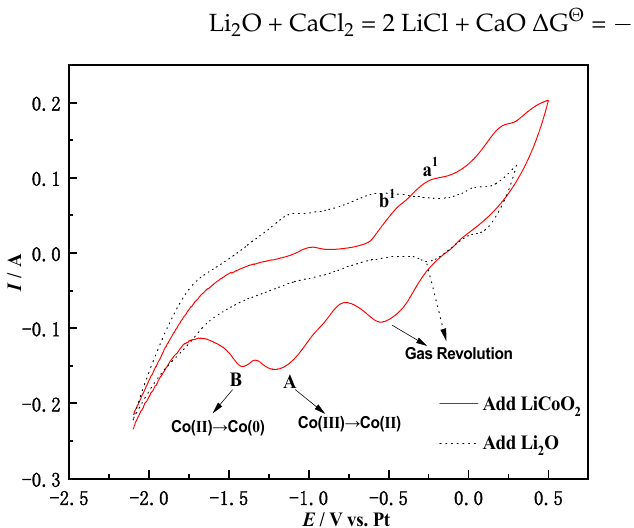
Figure 6. Comparison of cyclic voltammetry curves after addition of Li 2 O with LiCoO 2 (CaCl 2 -NaCl system 0.2 V/S Fe electrode).